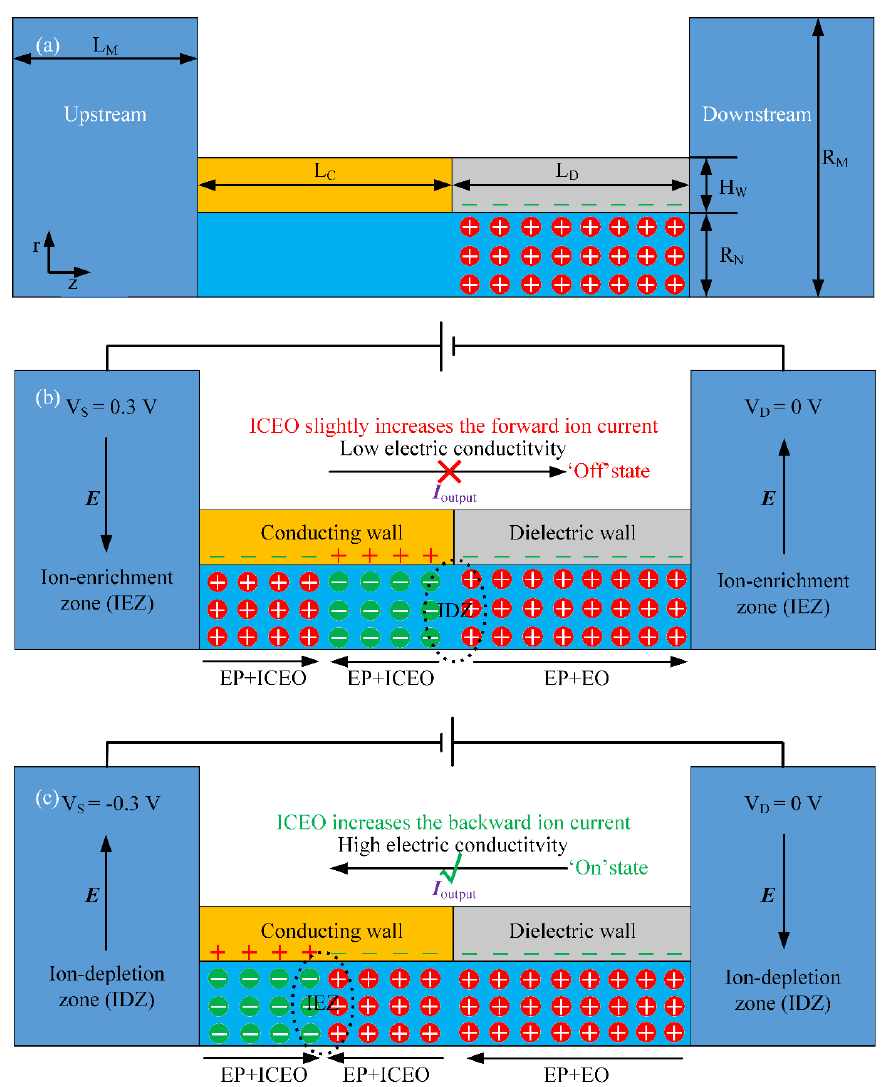
Figure 2. A 2D cross-sectional schematic diagram of the nanofluidic ion diode exploiting induced-charge electrokinetic (ICEK)-mediated internal ion concentration polarization (ICP) in a metal-dielectric Janus nanopore for achieving reliable ion current rectification in the r-z axisymmetric coordinate system, in which the dielectric wall is negatively charged and serves as a cation-selective medium. ( a ) Geometry and size of the nanofluidic device, as well as the spatial distribution of counterions and surface charge inside the nanopore without external voltage excitation. ( b , c ) In the presence of an external DC electric field, the combination of a bipolar induced double layer (IDL) within the metallic nanochannel and unipolar cations within the negatively-charged dielectric nanochannel gives rise to a voltage-adjustable non-uniform space free charge distribution, whose electrochemical transport along the nanopore results in ( b ) an ion-depletion zone (IDZ) in the midchannel for a positive DC bias and thereby the “o ff ” working state of the nanofluidic ion diode with the forward current being greatly weakened, or ( c ) an ion-enrichment zone (IEZ) in the center of the conducting wall for a negative DC bias and therefore the “on” working state of the ion circuit platform with the backward electric current being greatly